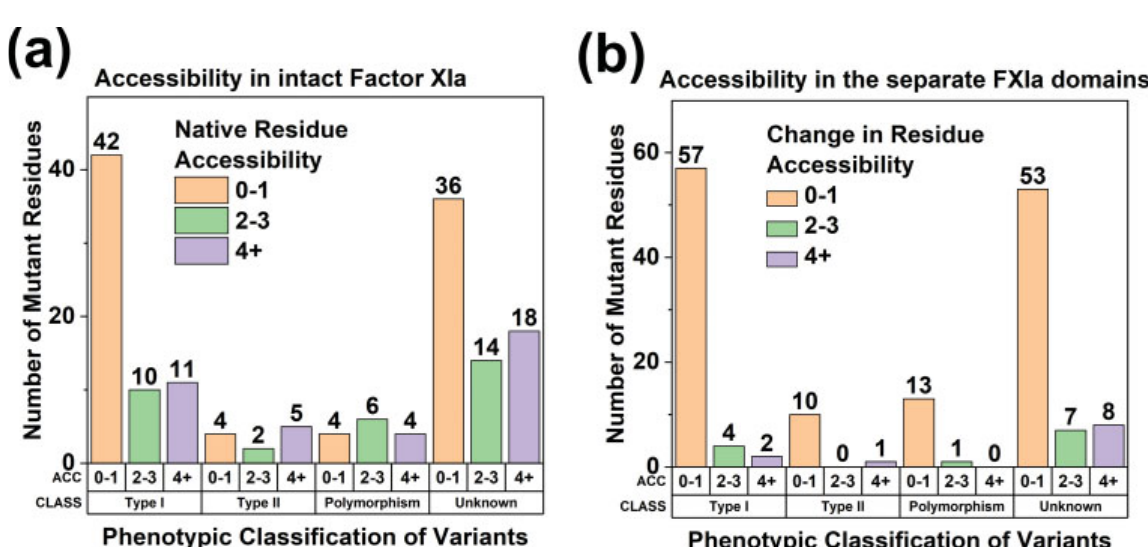
Fig.8 Accessibility analyses of 142 missense variants and 14polymorphismsinthe FXI proteinstructure. (a) FXI variantsinthe FXIastructureare grouped by phenotypicclassi fi cation (CLASS). The variants are further subdividedaccording tothe native residue accessibility (ACC) of the intact protein. Accessibility was determined using DSSP and is explained in detail in the Methods section. Accessibilities of 0 or 1 indicate sidechain burial and values > 1 indicate sidechain exposure to solvent. (b) FXI variants are again grouped by phenotypic classi fi cation (CLASS) and accessibility (ACC). Here, accessibility refers to the change in residue accessibility when the intact FXI protein is separated into fi ve distinct domains, namely the Apple1, Apple2, Apple3, Apple4 and SP